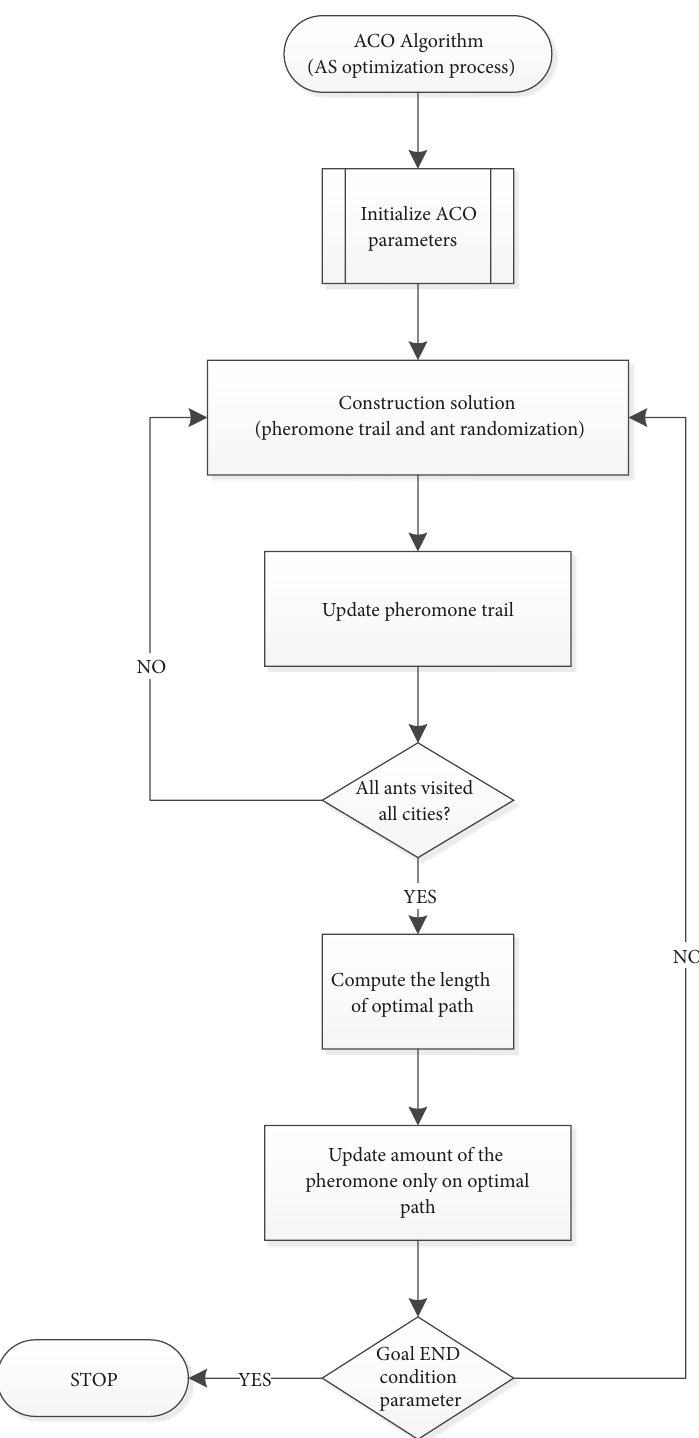
Figure 12: ACO flowchart optimization